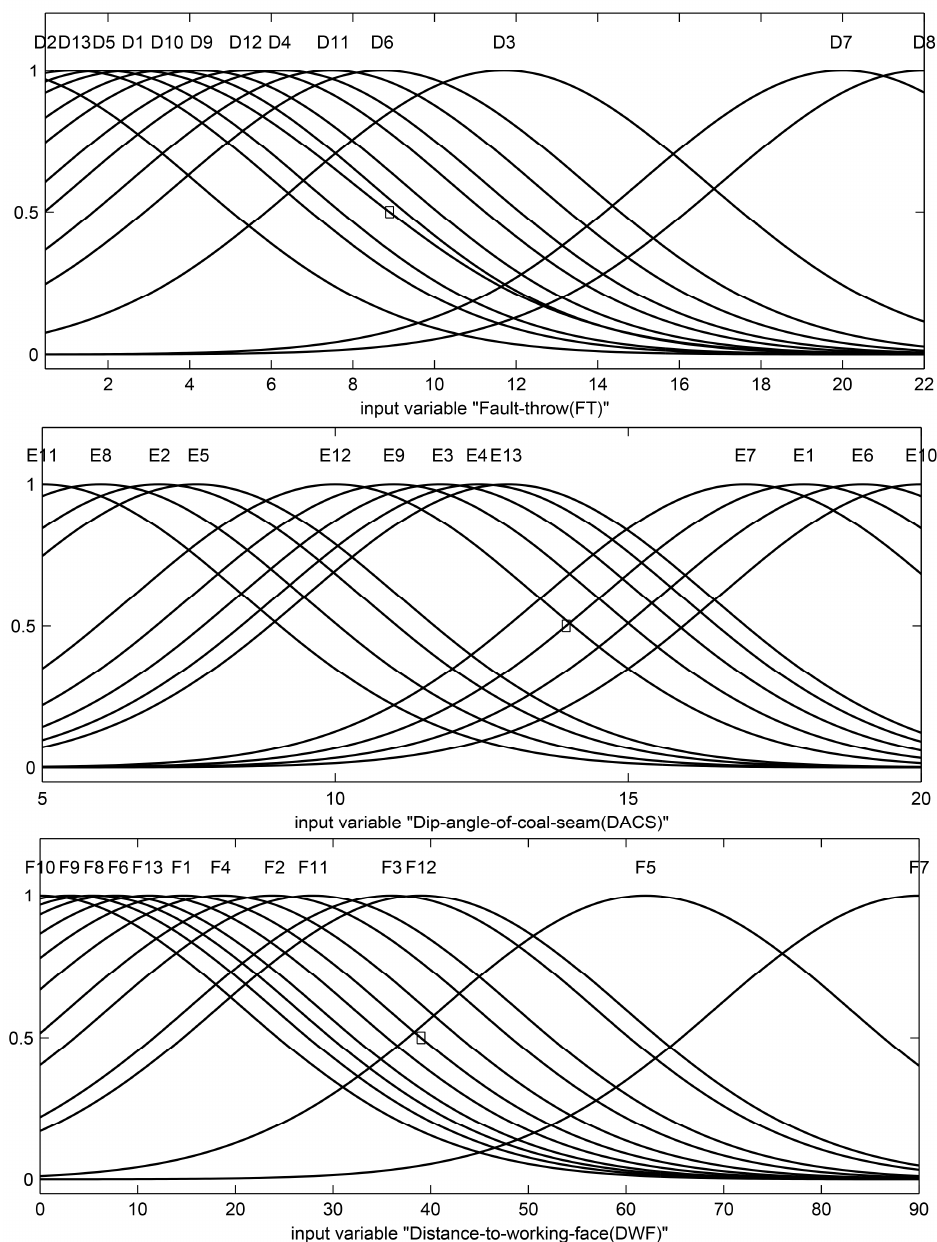
Figure 9. The shape of the membership functions after training (for parameters FT, DACS and DWF).